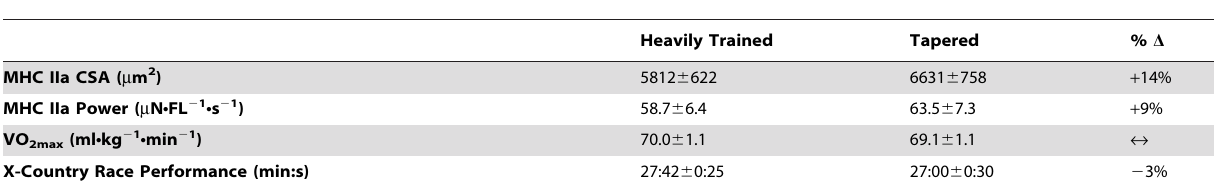
Table 1. Subject characteristics and physiological data (n=